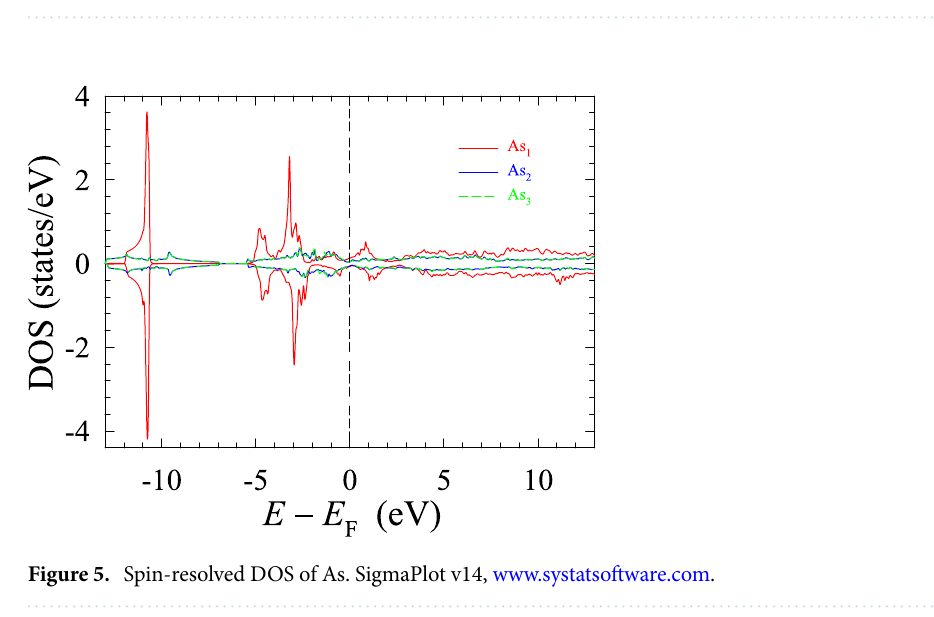
Energy band structure. The spin-resolved energy band structure of EuFeAs 2 is presented in Fig. 6. It is plotted along the k -paths passing through high symmetry directions in the conventional Brillouin zone shown in the middle of the figure. One notices in Fig. 6a that there is a dense concentration of nearly flat bands around 1.7 eV. These bands are related to the strongly localized Eu 4 f states. As one moves in the Brillouin zone from one symmetry point to another, they show almost zero dispersion. As the effective mass m ∗ of the carriers is inversely proportional to the band curvature, m ∗ ∼ [∇ 2 k E ( k ) ] − 1 , the electrons in these localized states cannot participate